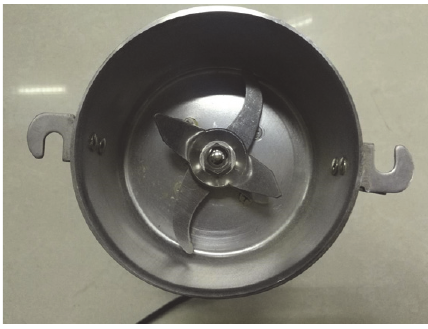
Figure 1: Blades of the knife